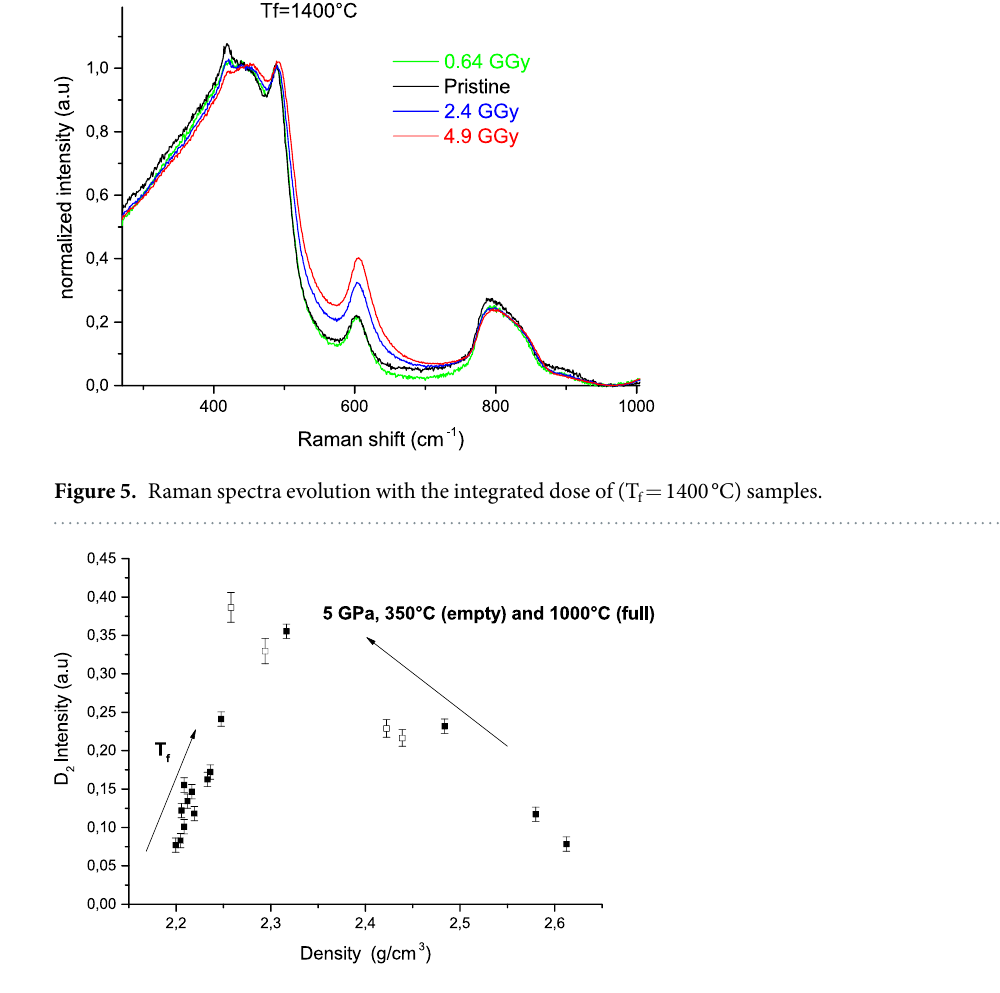
Figure 6. Raman D 2 band intensity as a function of density for HP-HT and T f